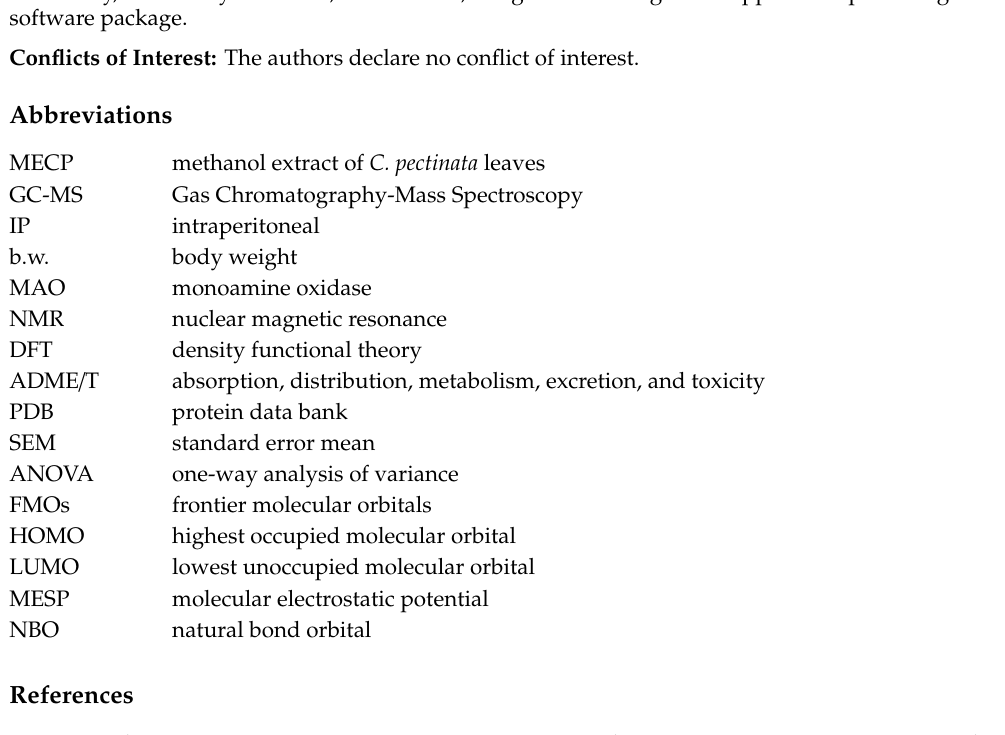
Table S1: Mulliken atomic charges and NBO charges at different atoms in gas phase of 5-chloro-1-(trimethylsilyl)- 1H-indole-2,3-dione 3-[O-(trimethylsilyl)-oxime] computed by B3LYP / methods with 6-31G + (d,p) basis set. Table S2: Mulliken atomic charges and NBO charges at different atoms in gas phase of cyclopentadecanone oxime computed by B3LYP / methods with 6-31G + (d,p) basis set. Table S3: Mulliken atomic charges and NBO charges at different atoms in gas phase of trans-2-dodecen-1-ol trifluoroacetate computed by B3LYP / methods with 6-31G + (d,p) basis set. Figure S1: Total ionic chromatogram (TIC) of MECP by GC-MS. Figure S2: Fourier transform Infrared- (FT-IR) spectrum of 5-chloro-1-(trimethylsilyl)-1H-indole-2,3-dione 3-[O-(trimethylsilyl)-oxime] (A); cyclopentadecanone oxime (B); trans-2-dodecen-1-ol trifluoroacetate (C), respectively in the wavenumber range 4000 – 0 cm-1. Figure S3: Calculated 1H-NMRisotropicchemicalshiftspectrumof5-chloro-1-(trimethylsilyl)-1H-indole-2,3-dione3-[O-(trimethylsilyl)-oxime] (A); cyclopentadecanone oxime (B); trans-2-dodecen-1-ol trifluoroacetate (C), respectively in chloroform solvent. Figure S4: Calculated 13C NMR isotropic chemical shift spectrum of 5-chloro-1-(trimethylsilyl)-1H-indole-2,3-dione 3-[O-(trimethylsilyl)-oxime] (A); cyclopentadecanone oxime (B); trans-2-dodecen-1-ol trifluoroacetate (C), respectively in chloroform solvent. Figure S5: 3D and 2D interactions of cyclopentadecanone oxime (A); trans-2-dodecen-1-ol trifluoroacetate (B); phenelzine (C), against the human monoamine oxidase A (PDB: 2Z5X) for antidepressant activity; Figure S6: 3D and 2D interactions of cyclopentadecanone oxime (A); trans-2-dodecen-1-ol trifluoroacetate (B); fluoxetine (C), against the human serotonin receptor (PDB: 5I6X) for antidepressant activity; Figure S7: 3D and 2D interactions of cyclopentadecanone oxime (A); trans -2-dodecen-1-ol trifluoroacetate (B); vincristine sulfate (C), against the human estrogen receptor (PDB ID: 1ERR) for cytotoxicity activity; Figure S8: 3D and 2D interactions of cyclopentadecanone oxime (A); trans-2-dodecen-1-ol trifluoroacetate (B); vincristine sulfate (C), against the epidermal growth factor receptor tyrosine kinase (PDB ID: 1M17) for cytotoxicity